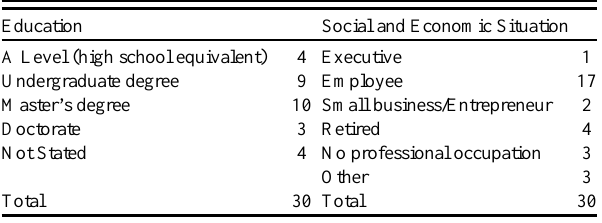
Table 1. Interviewees’ educational and socioeconomic